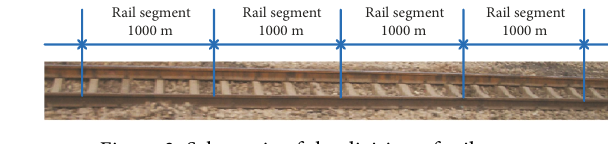
Figure 2. Schematic of the division of rail segments Table 1. Standards for severe rail defects in the Beijing